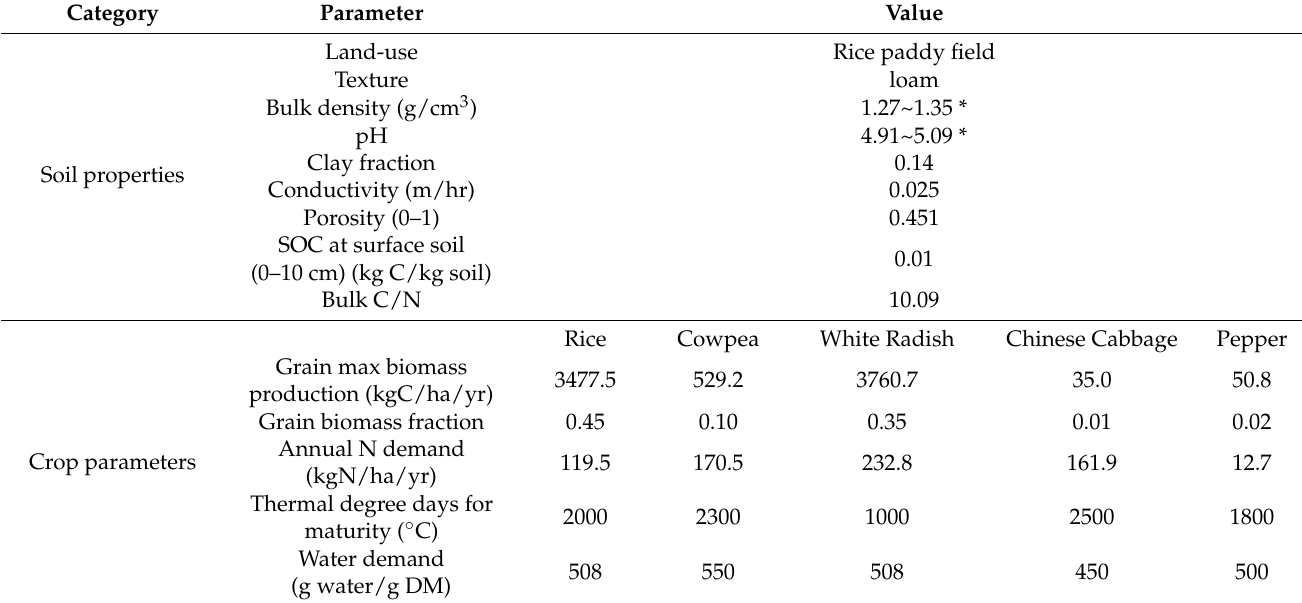
Table 2. The soil and crop parameters used by the DNDC